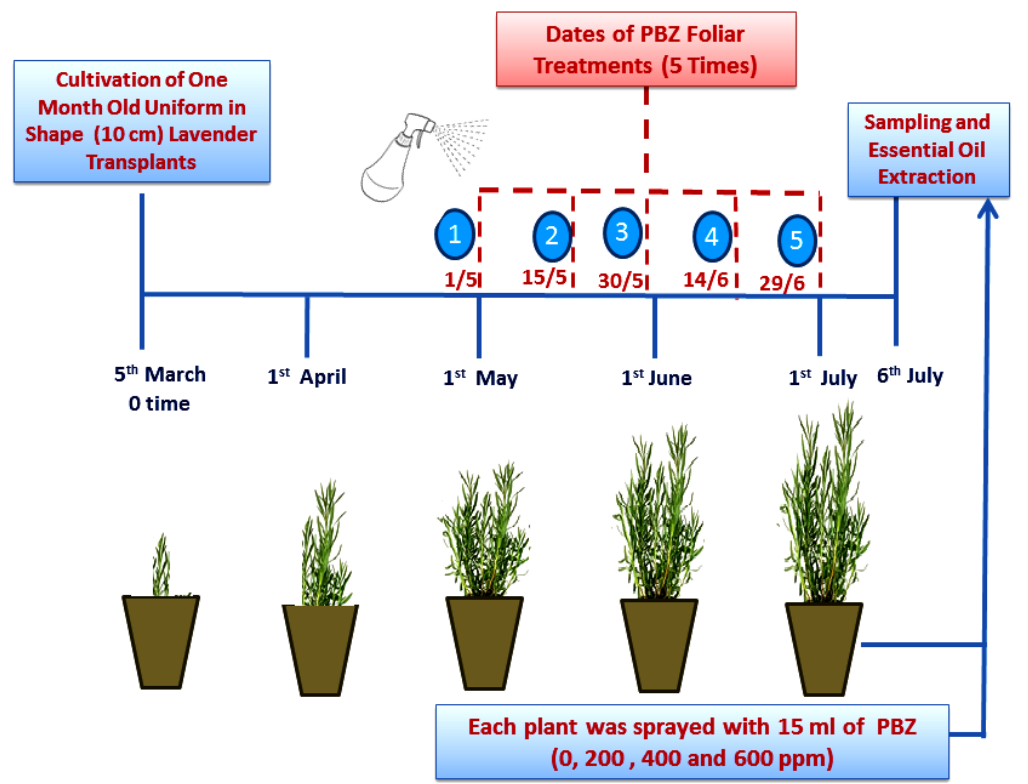
Figure 7. The timeline infographic for the treatments of paclobutrazol (PBZ), as a foliar application at 0, 200, 400, and 600 ppm and the sampling date, to extract the essential oil of lavender ( Lavandula officinalis L ) plants.